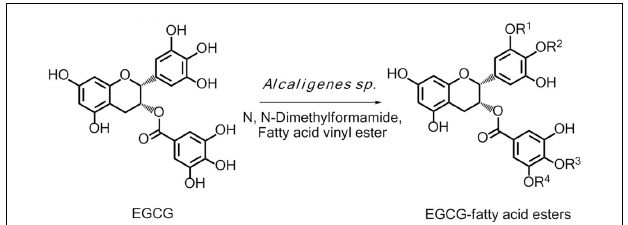
FIGURE 1 | Lipase-catalyzed synthesis of EGCG fatty acid esters. One or two of R 1–4 are substituted with fatty acids.